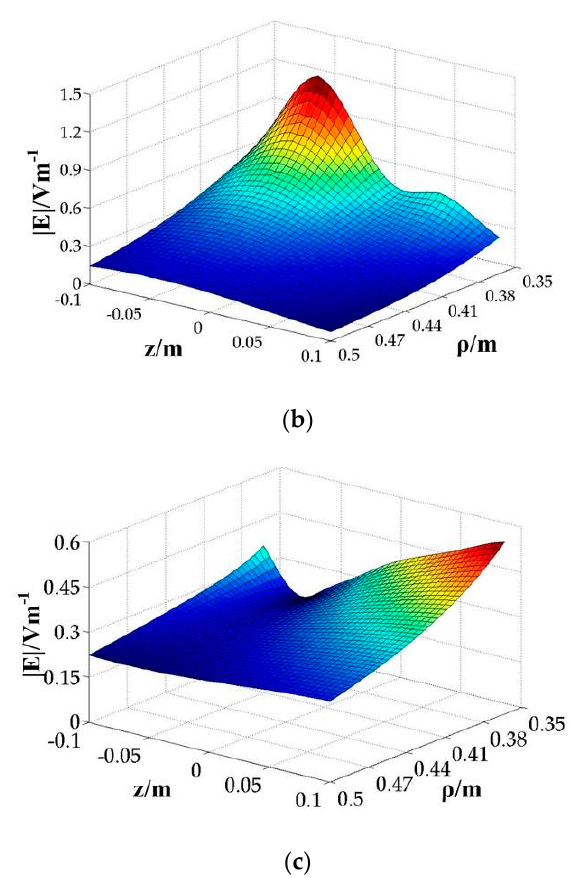
Figure 6. The electric field strength around WPT systems: ( a ) the WPT system without shielding coils; ( b ) the series-opposing structure WPT system; ( c ) the inductive structure WPT system.